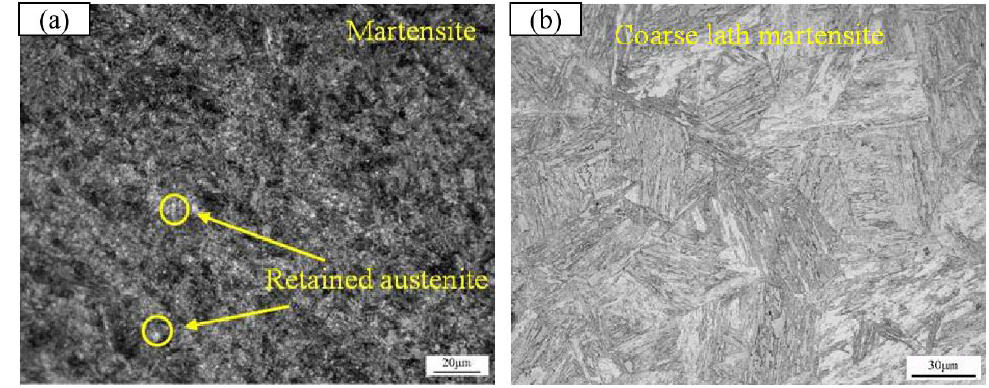
Figure 3. Comparison of base metal and inverted martensite in the coarse-grained region.